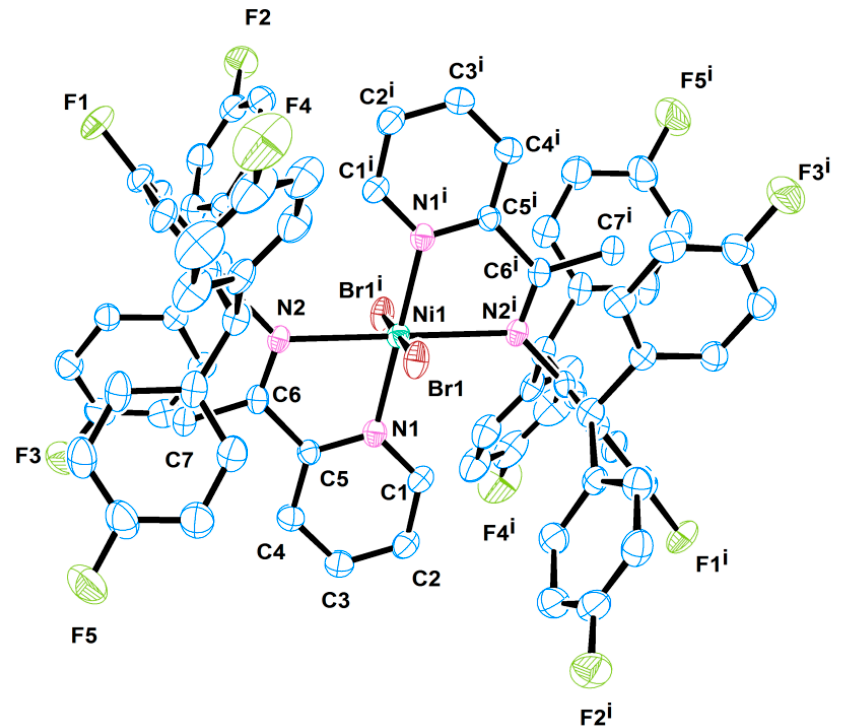
Figure 3. ORTEP drawing of bis-ligated Ni4 ′ with thermal ellipsoids shown at a probability level of 30%. All the hydrogen atoms have been omitted for clarity. The atoms labelled with an ‘i’ superscript have been generated by symmetry.